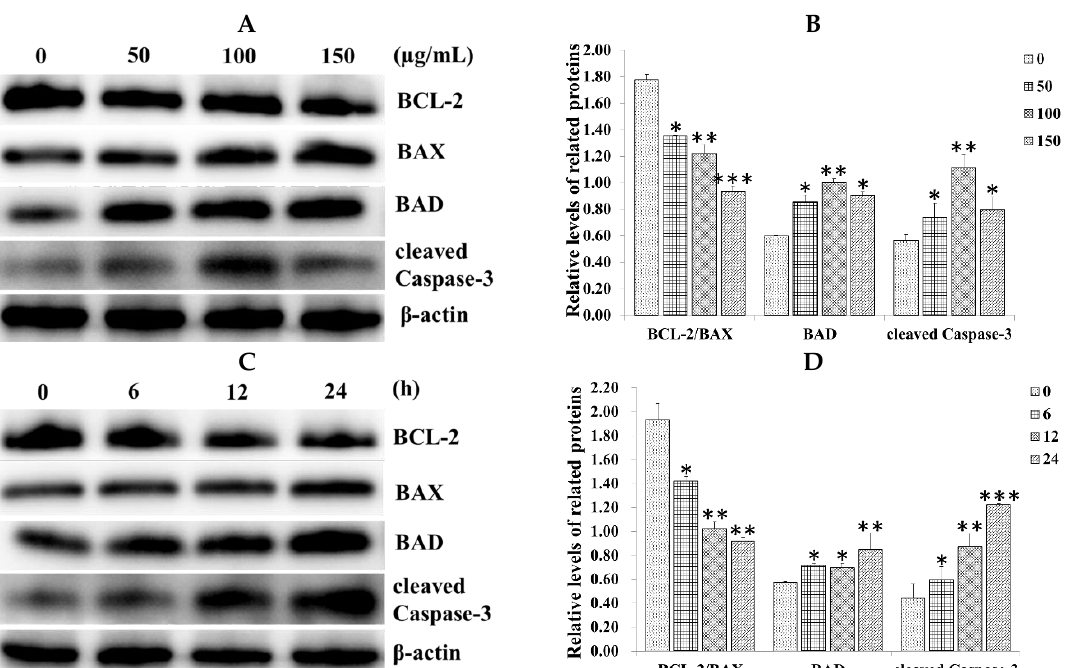
Figure 3. SiNPs induced the expression of the apoptosis-related proteins in RAW 264.7 macrophage cells. ( A , B ) The expression of B-cell lymphoma 2 (BCL-2), BCL-2-associated X protein (BAX), BCL-2-associated death promoter (BAD), and cleaved Caspase-3 was analyzed via western blot analysis. Cells were exposed to different concentrations of SiNPs (0, 50, 100, and 150 µg/mL) for 12 h. ( C , D ) Cells were exposed to different times (0, 6, 12, and 24 h) with 100 µg/mL SiNPs. Analyses of the band intensity on the films are presented as the relative ratio of the related proteins to β-actin. Statistical analysis is shown in the bar graphs. Data are presented as the mean ± SDM of three independent experiments. Statistically different from the control is marked with asterisks (* p < 0.05, ** p < 0.01, and *** p < 0.001).